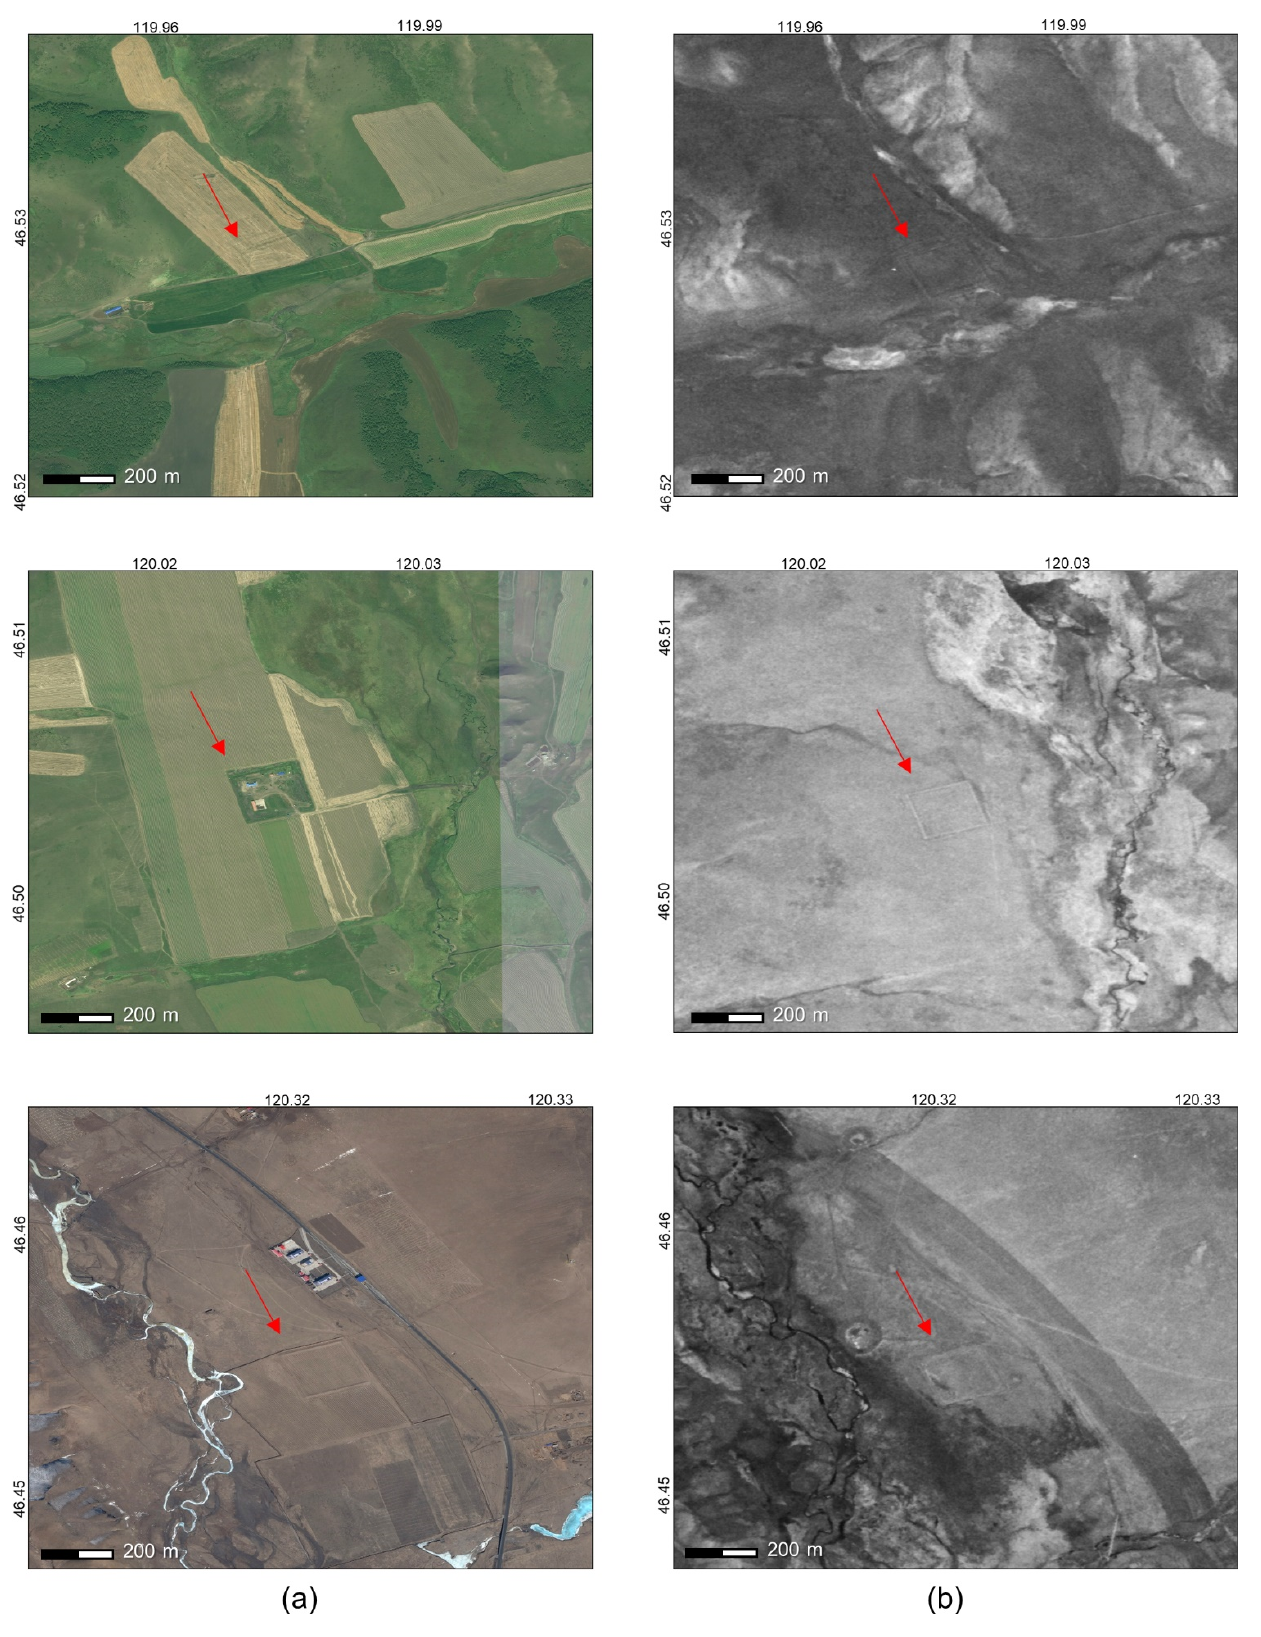
Figure 8. Forts in the Mongolian Arch area: ( a ) forts on Bing Maps and ( b ) forts on CORONA imagery.